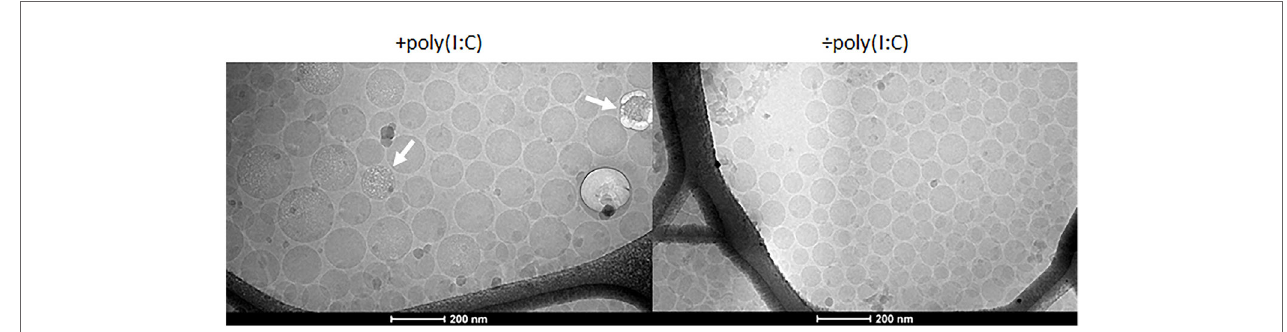
FigUre 1 | Representative cryo-transmission electron microscopy images of cationic adjuvant formulation 24a with (left) and without (right) poly(I:C). The beam damage observed in association with the emulsion droplets (arrows) may be a result of the presence of electron-dense